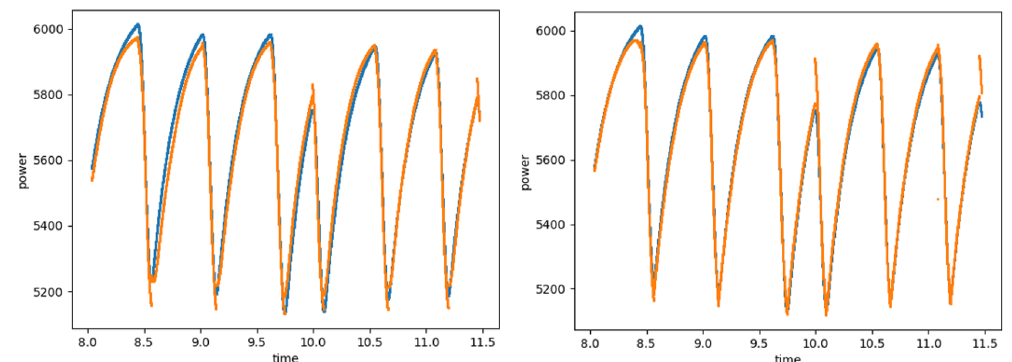
Figure 17. Comparison with Mode 1 ( left ) and Mode 2 ( right ) in three-layer networks.